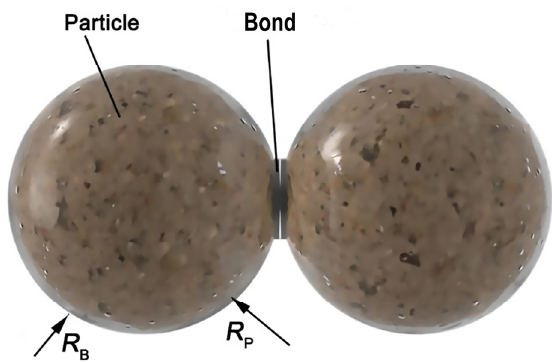
Figure 2. The bond relationship between the wet soil